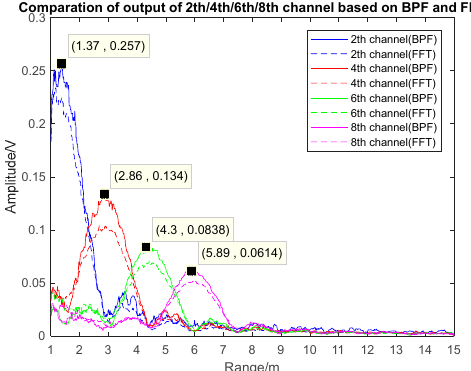
Figure 7. A comparison of the 2th/4th/6th/8th harmonic channels based on the BPF and FFT scheme (SNR = − 10 dB).